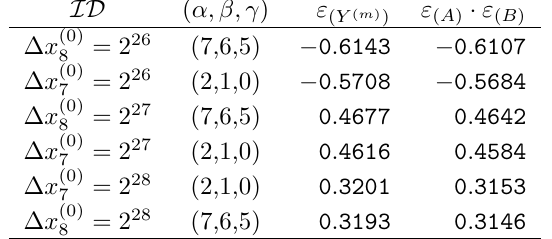
Table 4: Best dual bit differentials for m = 4, characterized by α, β and i